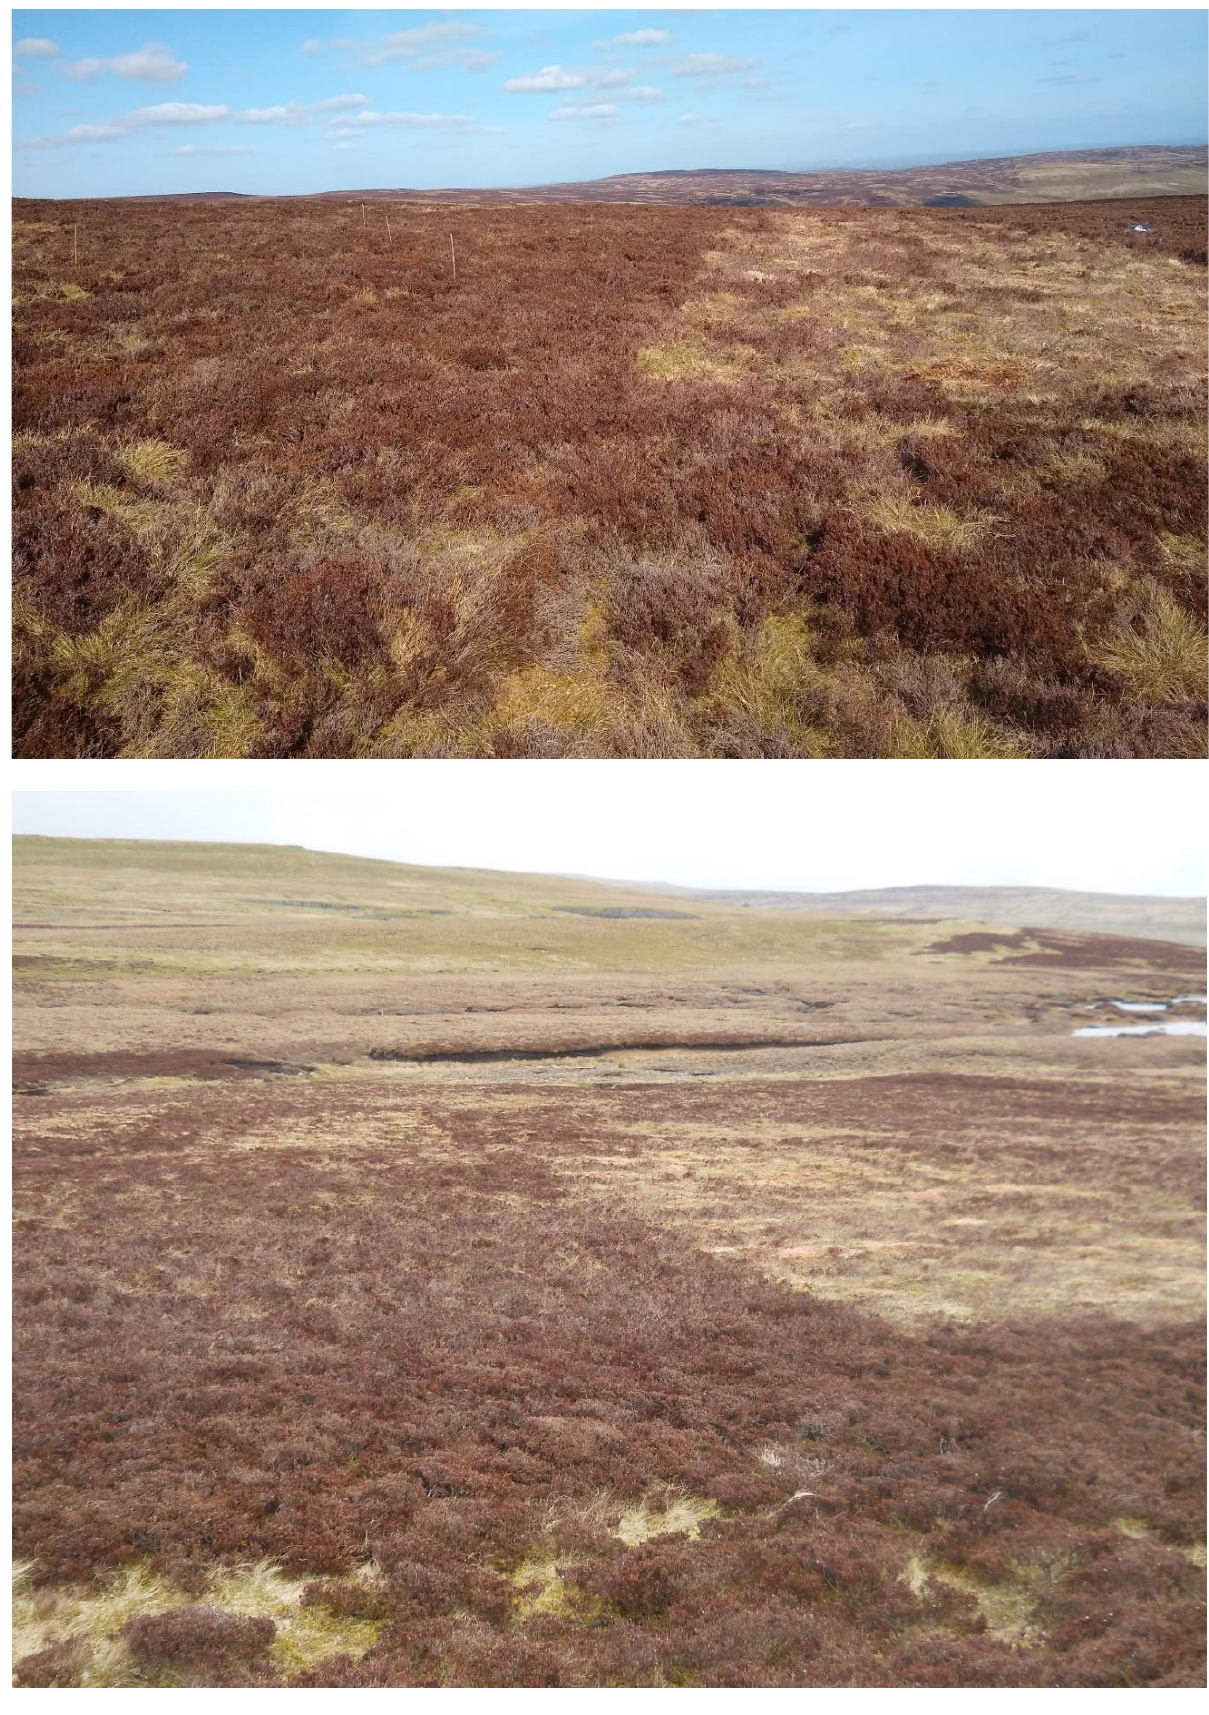
Figure 1. Paired cut and control treatment plots on Site A (top) and Site B